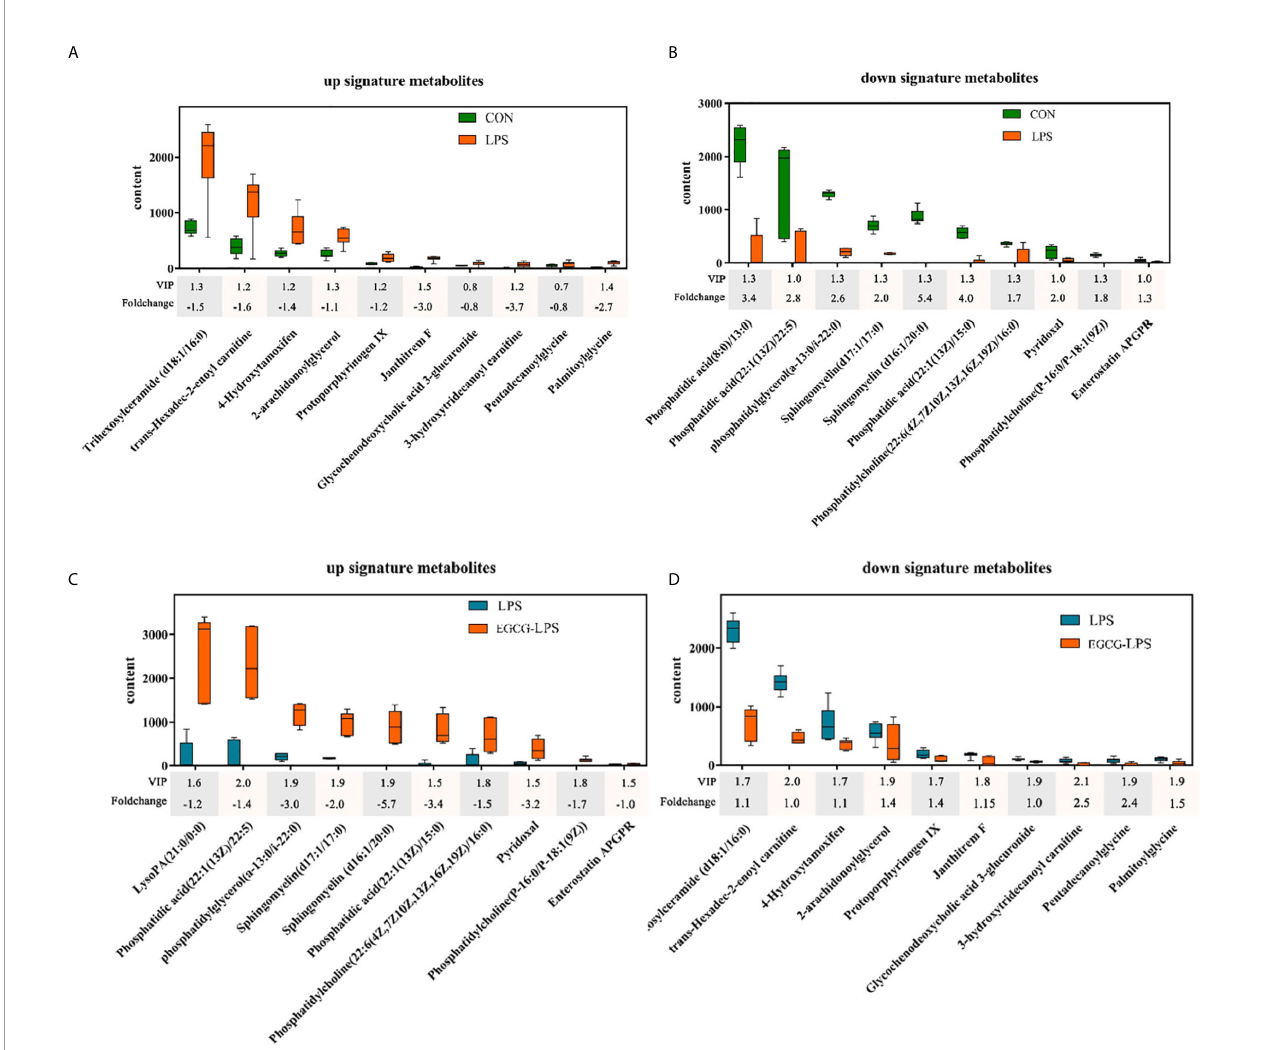
FIGURE 8 | The regulatory effect of the intragastric administration of EGCG on mouse serum metabolites. (A) Compared with the CON group, ten characteristic metabolites increased in the LPS group ; (B) Compared with the CON group, ten characteristic metabolites reduced in the LPS group; (C) Compared with the LPS group, ten characteristic metabolites increased in the EGCG-LPS group; (D) Compared with the LPS group, ten characteristic metabolites reduced in the EGCG- LPS